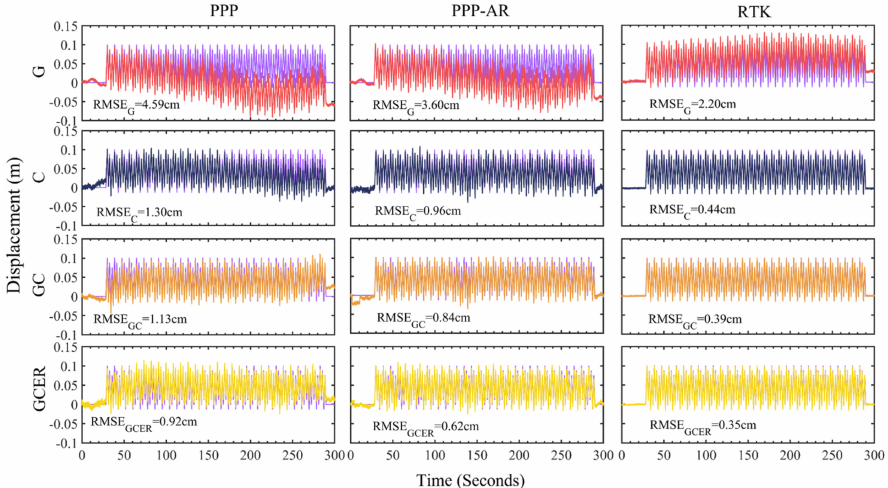
Figure 8. Sinusoidal displacement time series from the LDT (purple) and different satellite systems derived from (left column) PPP, (middle column) PPP-AR, and (right column) RTK techniques (starting from 08:32:00). From top to bottom, results, respectively, were computed from G (red), C (dark blue), GC (orange), and GCER (yellow) observations,